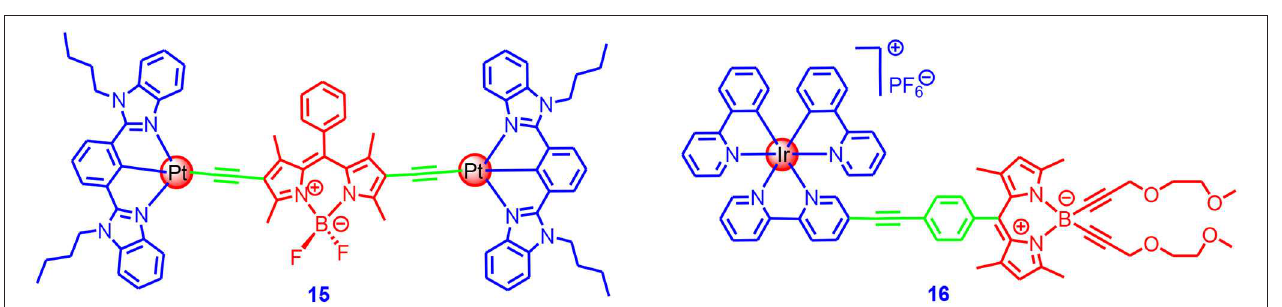
FIGURE 5 | N ∧ C ∧ N Pt(II)–acetylide complex and Ir(III)(ppy)(bpy) complex contains Bodipy